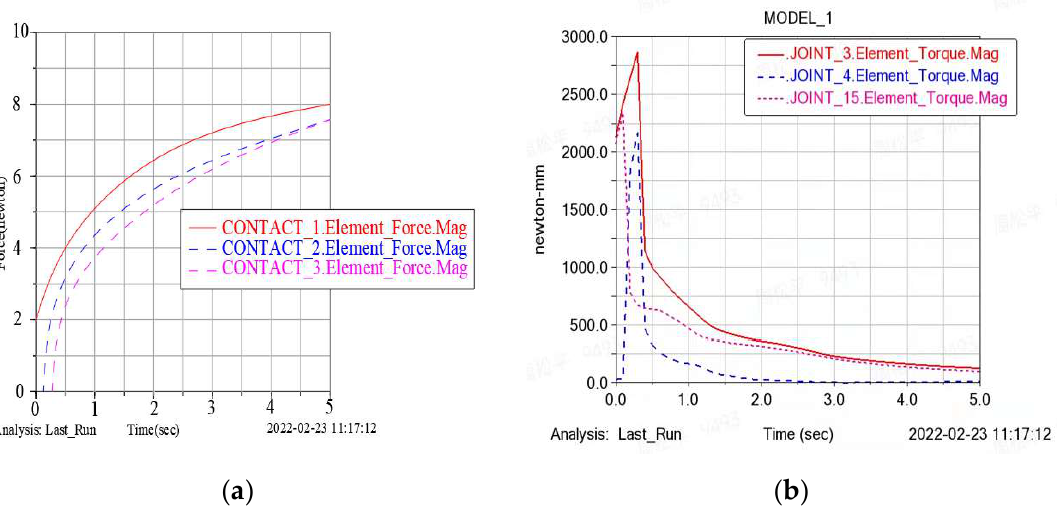
Figure 8. Simulation analysis diagram. ( a ) Flexible finger torque variation graph; ( b ) Clamping finger displacement velocity variation graph.